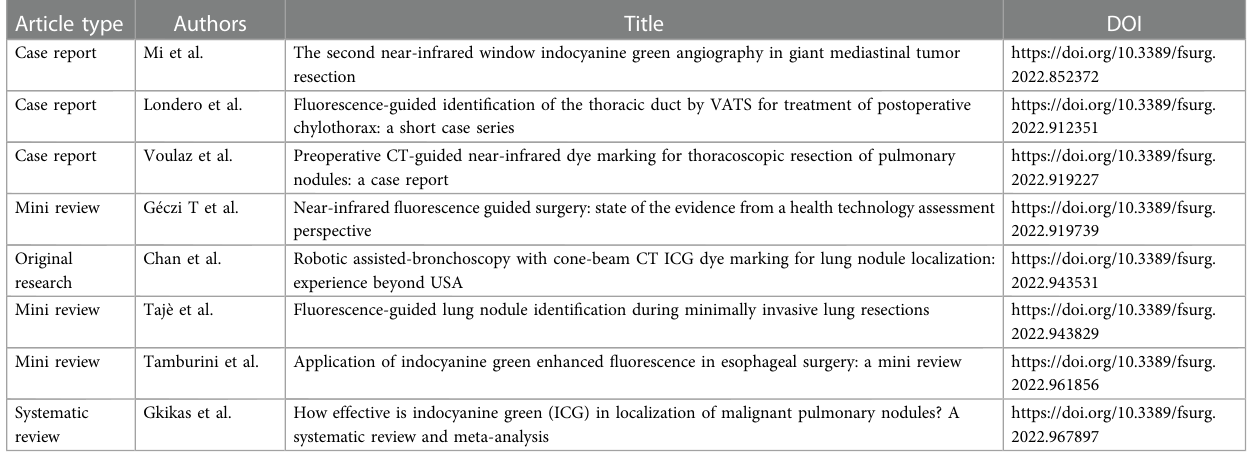
TABLE 1 Articles published within the research topic of Frontiers in surgery : near-infrared fl uorescence guided surgery: state of the evidence from a health technology assessment